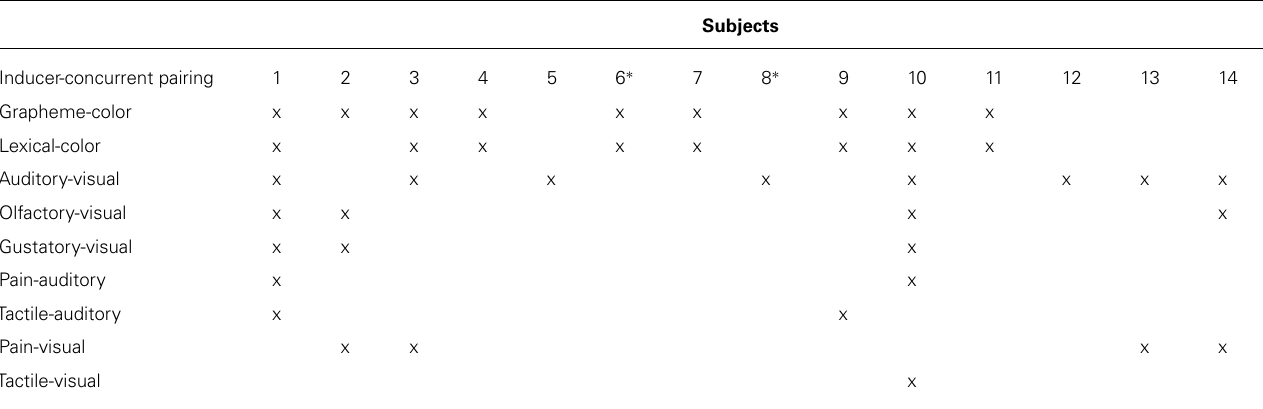
Table 1 | Specification of the synesthesia